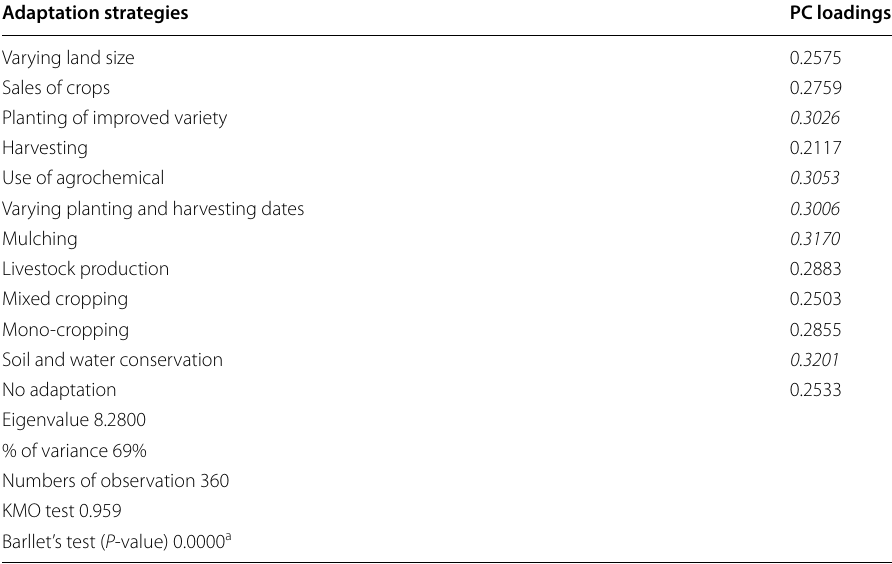
a Represents significance level at 1%